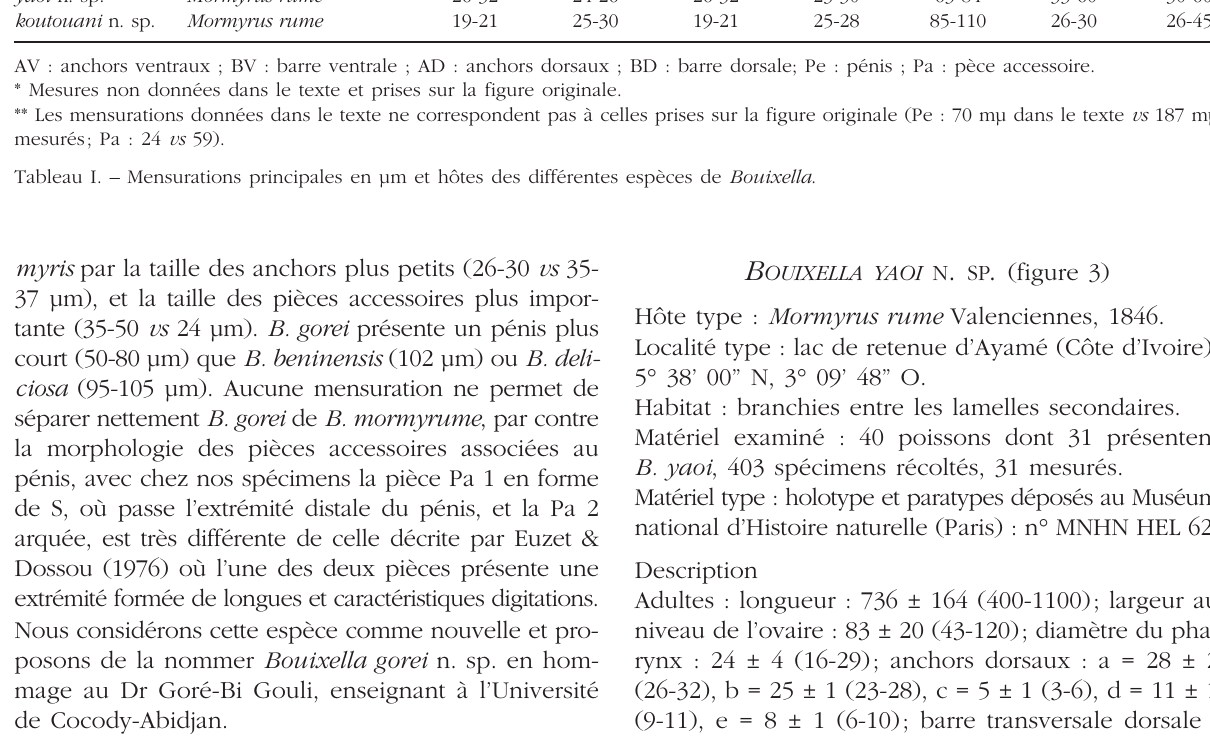
Tableau I. – Mensurations principales en µm et hôtes des différentes espèces de Bouixella